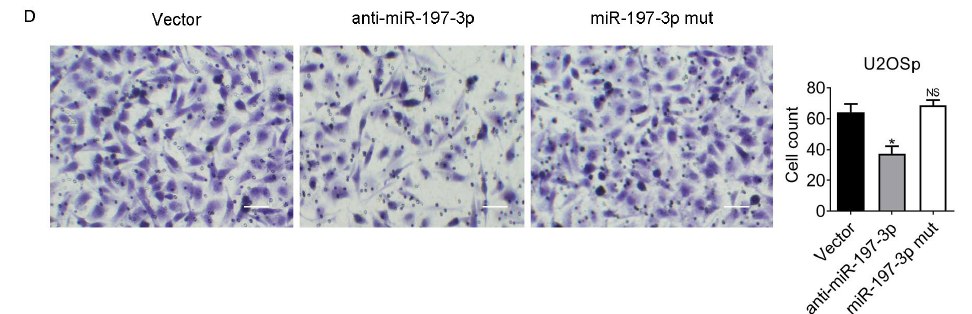
Figure 5. The miR-197-3p-SPOPL axis is crucial for preserving osteosarcoma stemness and chemore- sistance. Cells were transfected with vector, anti-miR-197-3p, or miR-197-3p. After 24 h, the cells were exposed to 2 µM MTX for 24 h. The following experiments were then performed: ( A ) The indicated gene expression in the cells was detected by qRT-PCR and Western blot. ( B ) The viability of the cells was assessed by MTT assay. ( C ) The representative images of CD133+ cells are shown. The CD133+ cell population was measured by flow cytometry. SSC-A indicates Side-Scatter Area. ( D ) The migration of the cells was assessed by transwell assay. Magnification, 200 × . * p < 0.05; NS, no significance. Results represented the mean ± S.D. of three independent experiments. U2OSp, the parental U2OS. MG63p, the parental